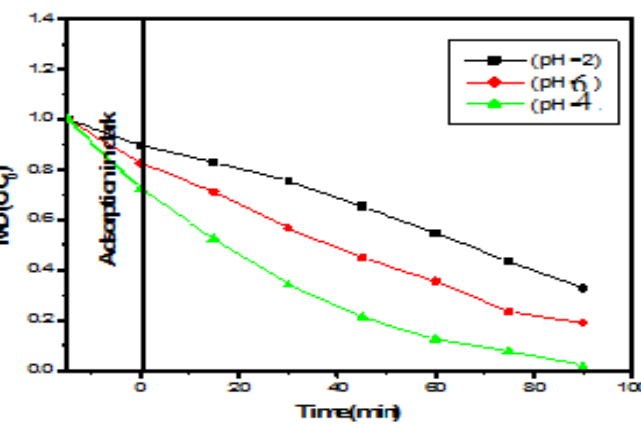
Fig. 10. Effect of pH on photodegradation of